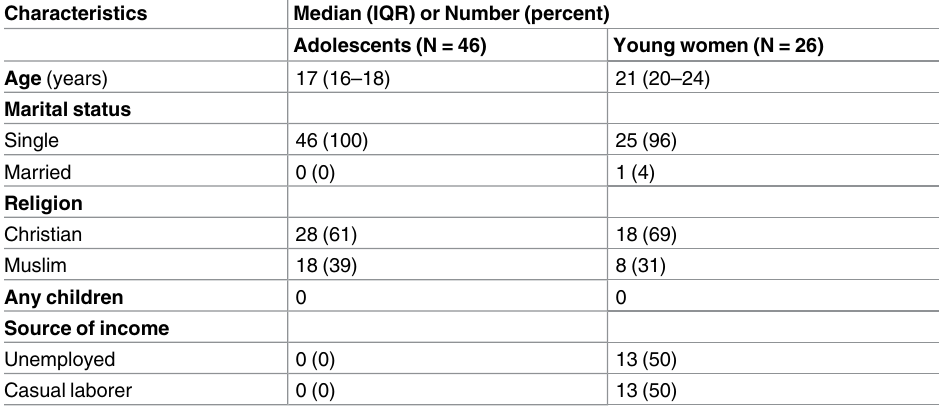
Table 1. Baseline characteristics of adolescent girls and young women.